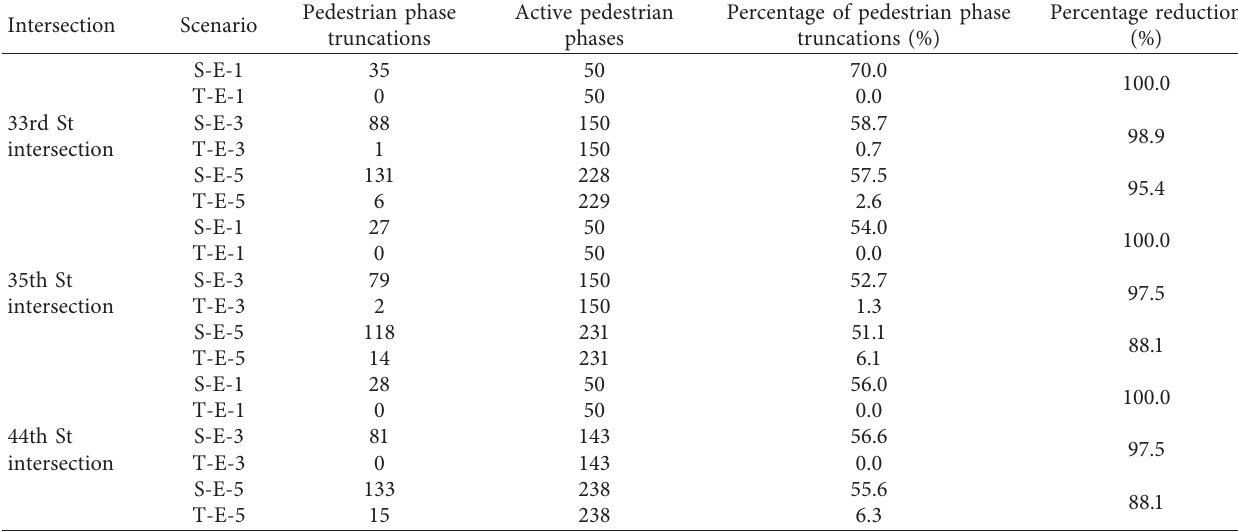
Table 4: Pedestrian phase cutoffs for the scenarios with EB trains.